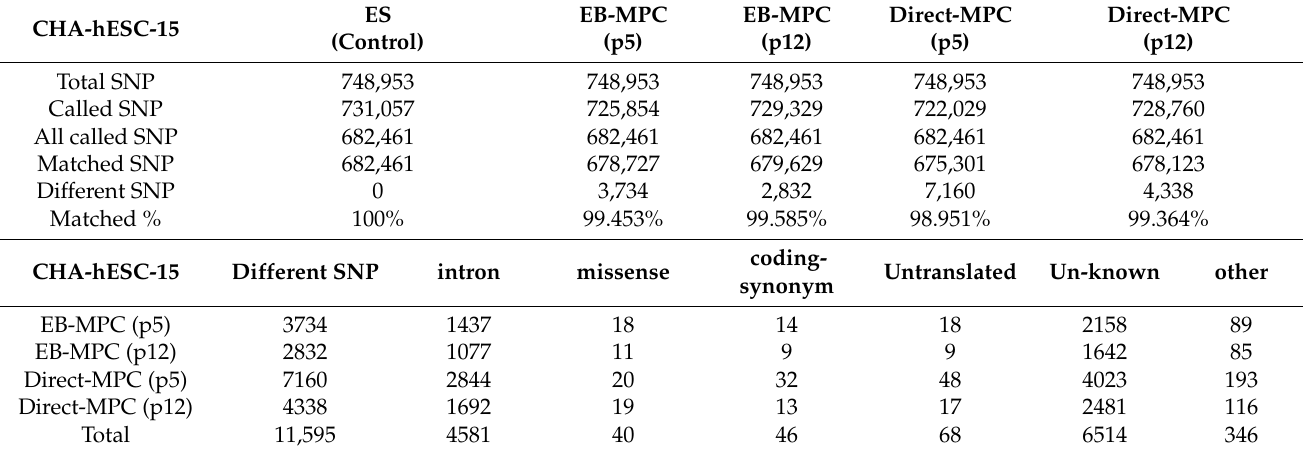
Table 1. SNP analysis of CHA-hESC-15 derived MPCs by array-based comparative genomic hybridization.